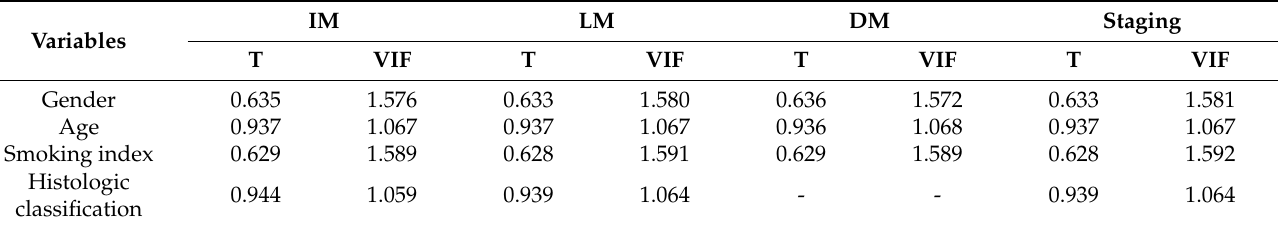
Table 6. Collinearity examination of multifactor analysis for basic condition and tumor markers related with metastasis and stage of patients with